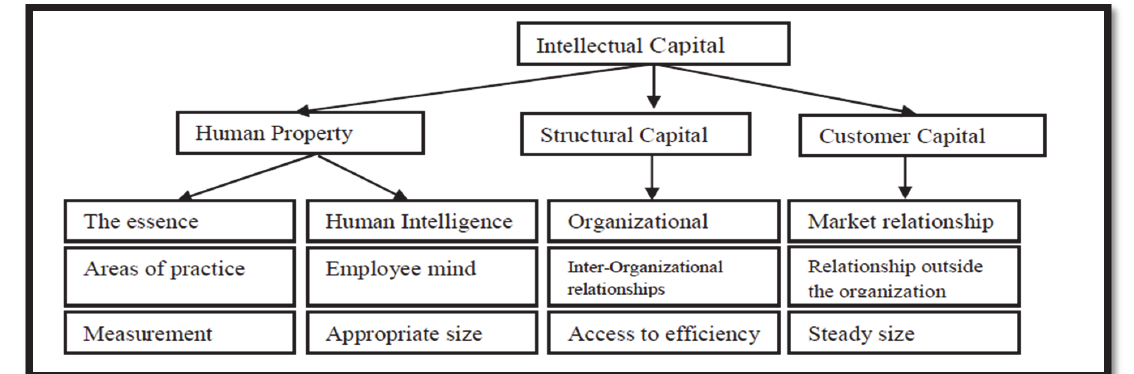
Fig. 1. The Multiple Dimensions of Intellectual